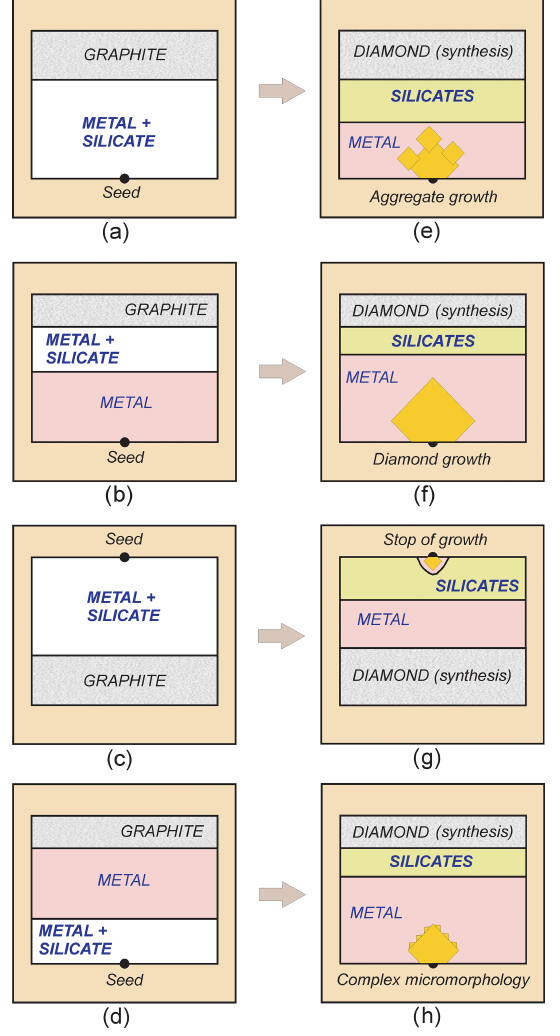
Figure 1. Schematic vertical cross sections of high-pressure sample assembly configurations used in experiments for diamond growth together with silicate minerals (a–d) , and sketch drawing of the re- spective run products (e–h) . (a) Basalt is evenly mixed with metal powder, and the diamond seed is located at the bottom of the cham- ber; (b) similar configuration but the lower part of initial metal does not contain basalt; (c) basalt is evenly mixed with metal powder, and the diamond seed is located at the top of the chamber; (d) the diamond seed is located at the bottom of the chamber and is cov- ered with a thin layer of a mixture of metal and basalt – the rest of the sample is a basalt-free Fe–Ni metal. Note that after experiments newly formed silicate phases were found mainly in the upper part of the chamber. Growth of diamond on a seed crystal occurred in the form of monocrystals (f) , crystals of complex micromorphol- ogy with growth pyramids present on (111) faces (h) , or as parallel- growth aggregates (e) . Only a little diamond growth was observed when the seed crystals were placed at the top of the chamber (g) . For further explanation of run products the reader is referred to the Results section and to Table 1.